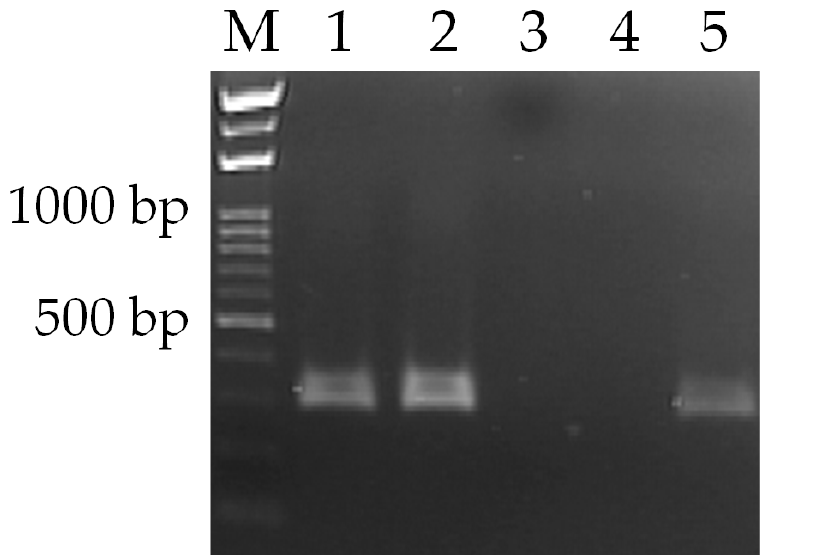
Figure 9. Agarose gel electrophoresis of the RT-PCR yield. Lane (M): DNA ladder; lanes (1 and 2): positive control from the conventional PCR machine; lane (3): negative control from the conventional PCR machine; lane (4): negative control from the oscillating thermocycler; lane (5): positive control from the oscillating thermocycler.